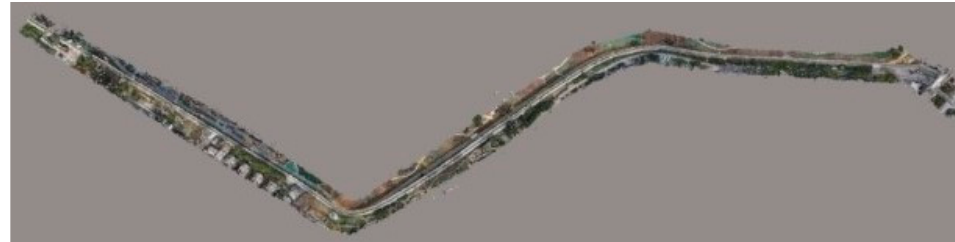
Figure 13. The 3D model of the study area.